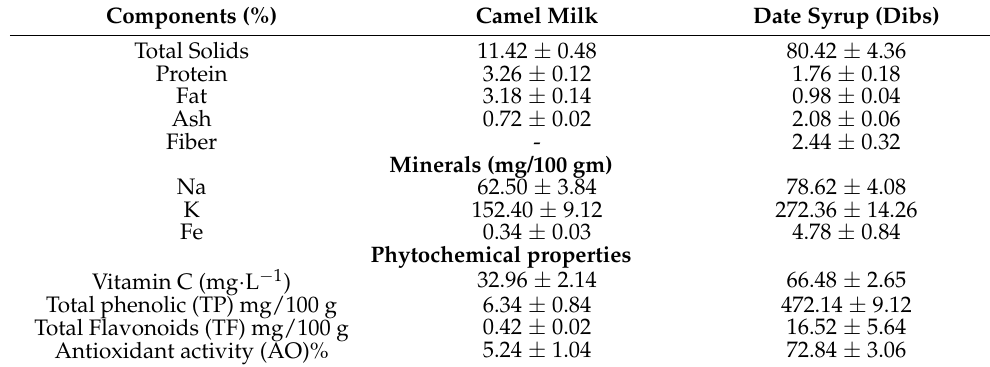
Table 1. Chemical composition, minerals content, and phytochemical properties of fresh camel milk and date